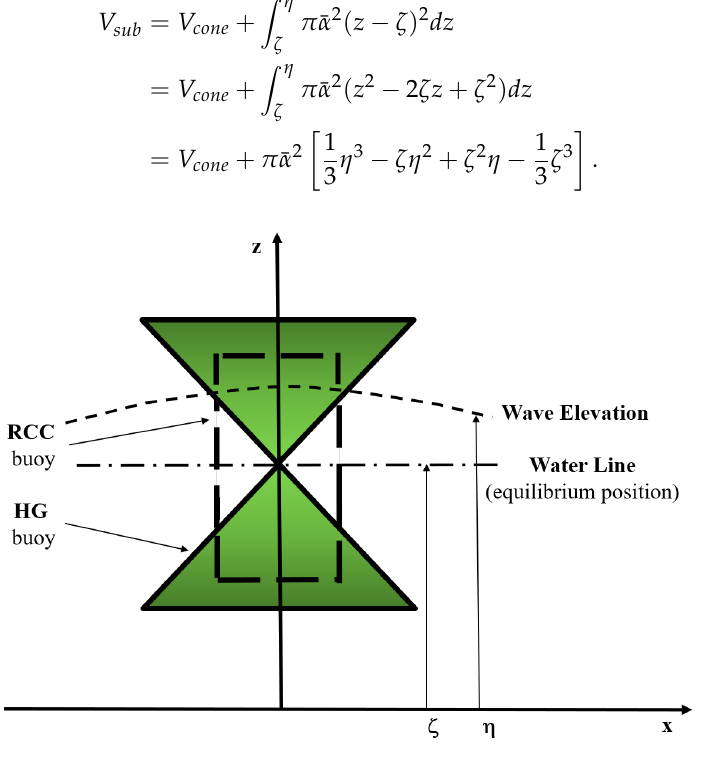
Figure 7. WEC HG and RCC buoy geometry 2D cross-sectional